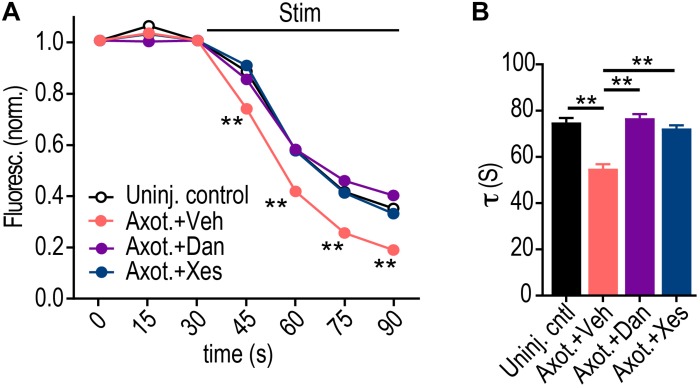
Dantrolene or Xestospongin C applied at the time and location of axotomy prevent retrograde enhancement of presynaptic release rate. (A) FM unloading curves at 48 h following application of vehicle or Dantrolene (20 μM) or Xestospongin C (1 μM) to axons for 1 h during axotomy. Uninjured control: n = 1076 puncta; Axot. + Veh: n = 893 puncta; Axot. + Dan: n = 1136 puncta; Axot. + Xes: n = 2234; 5 chambers per condition over two experiments. Two-way ANOVA, Bonferroni post hoc test. (B) FM decay time constant (τ) for puncta with τ < 360 s (Uninj. control: n = 1045; Axot. + Veh: n = 857; Axot. + Dan: n = 1058; Axot. + Xes: n = 2139). Unpaired two-tailed t-test. Each condition includes 5 chambers combined over 2 independent experiments. Error bars, SEM. ∗∗p < 0.005.